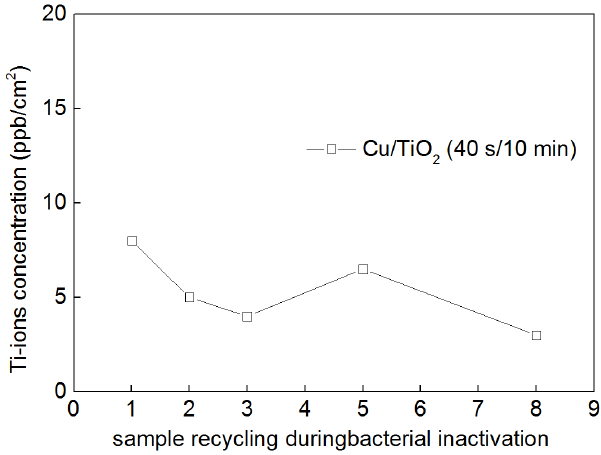
Figure 5. Ti-ions release from a diverse TiO 2 /Cu (10 min/40 s) cotton sputtered sample as a function of catalyst cycling up to the eighth cycle.